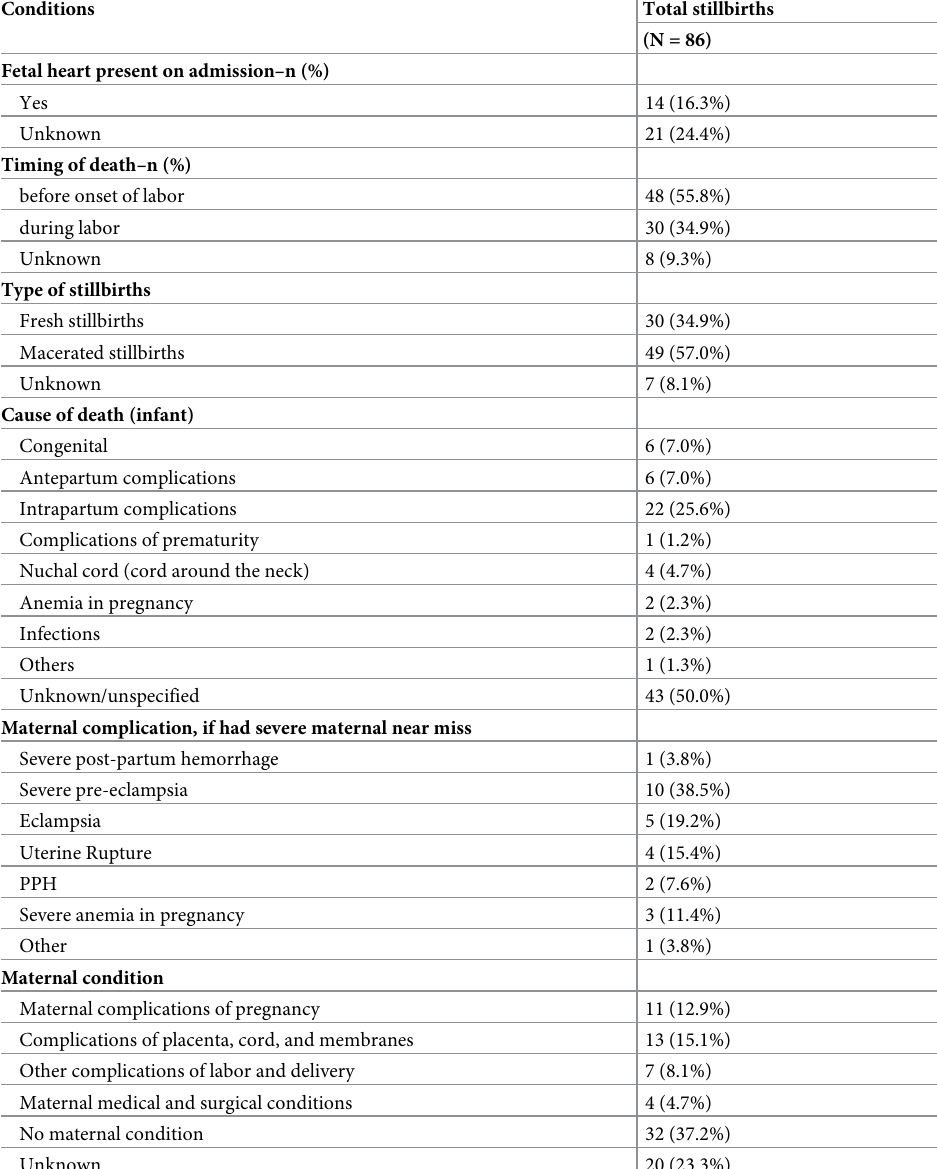
Table 3. Characteristics of